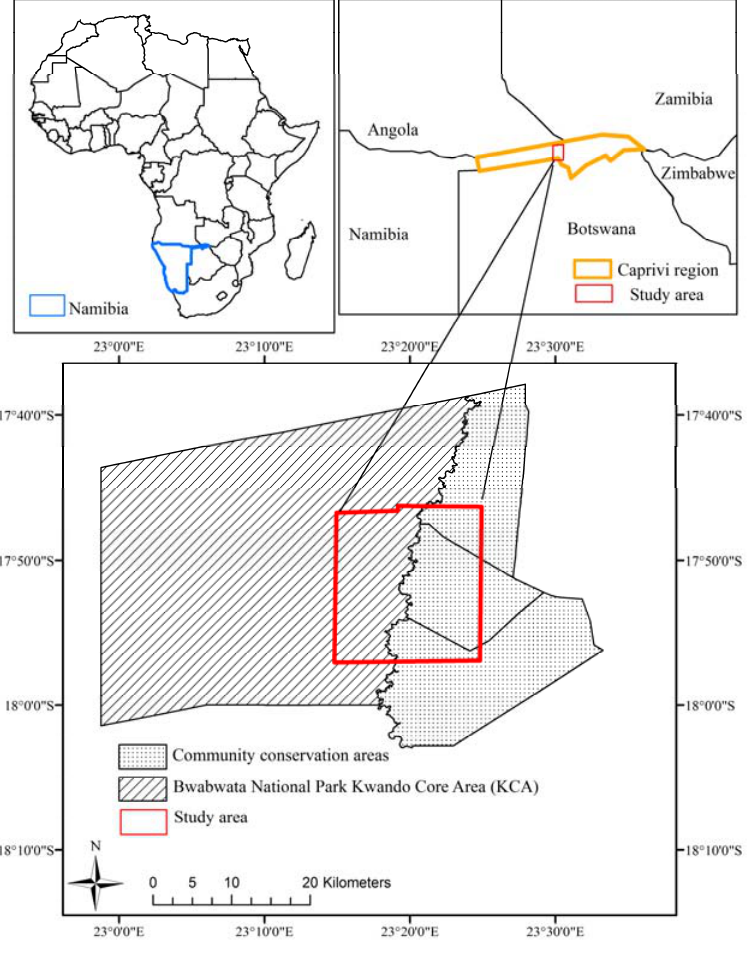
Figure 1. Study area showing the larger regional context and the boundaries of the two dominant land management types used in the